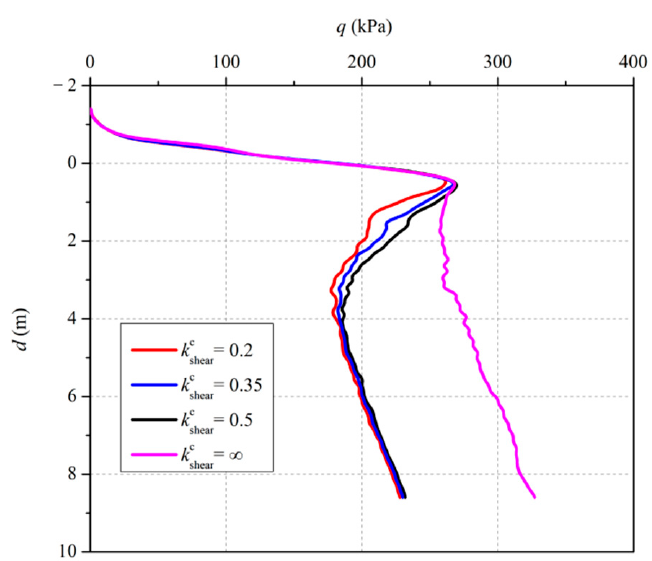
Figure 7. Penetration resistance profiles with different critical thresholds.